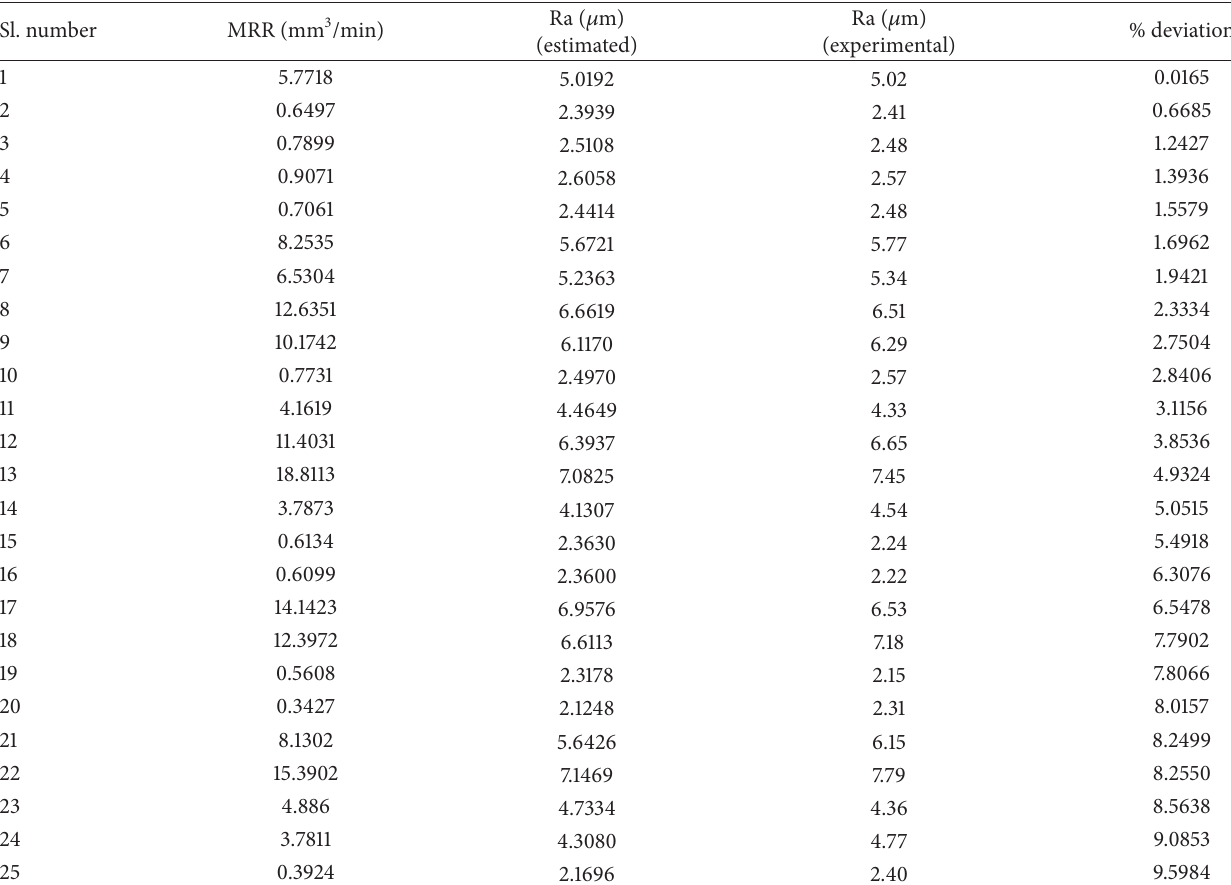
Table 5: Validation of Pareto front